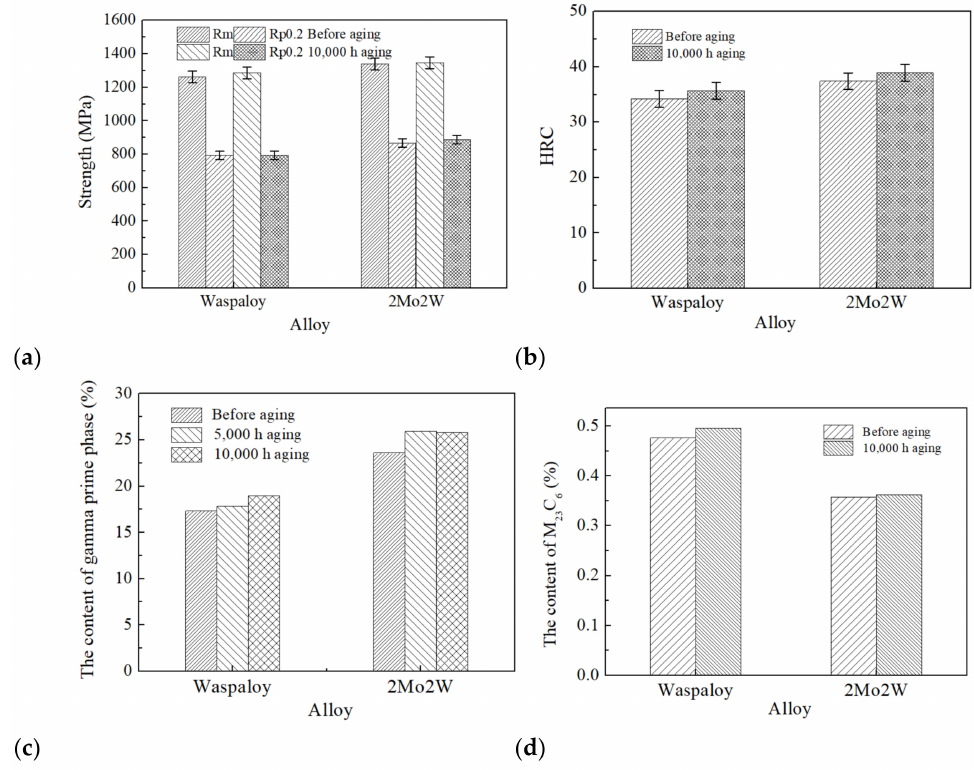
Figure 9. Strengths and precipitate compositions of 2Mo2W alloy and Waspaloy. ( a ) Strength; ( b ) Hardness; ( c ) The content of the γ (cid:48) phase; ( d ) The content of M 23 C 6 carbide. The γ (cid:48) phase contents of the two alloys prior to aging and after 5000 h and 10,000 h are compared in Figure 9c. The γ (cid:48) phase content in the 2Mo2W alloy was significantly